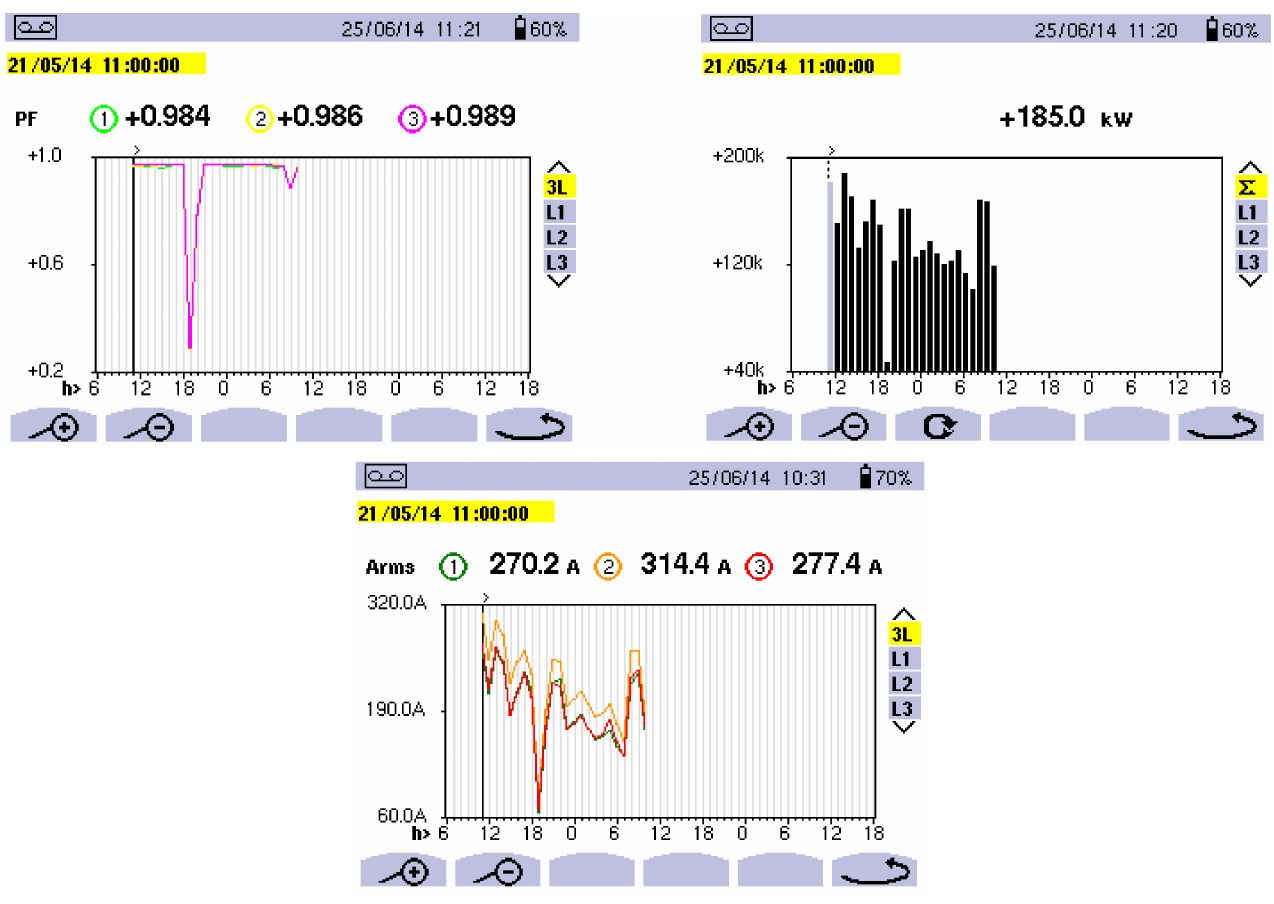
Figure 3. Recorded instant power, power factor and